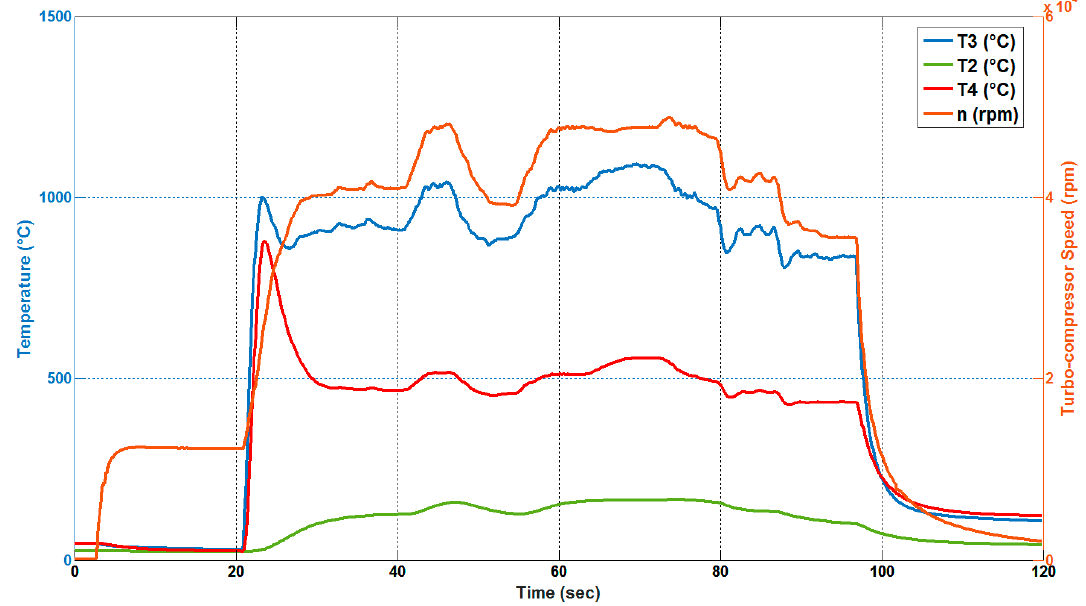
Figure 12. The measured parameters of the iSTC-21v turbojet engine that are usable for infrared thermography-based diagnostics.